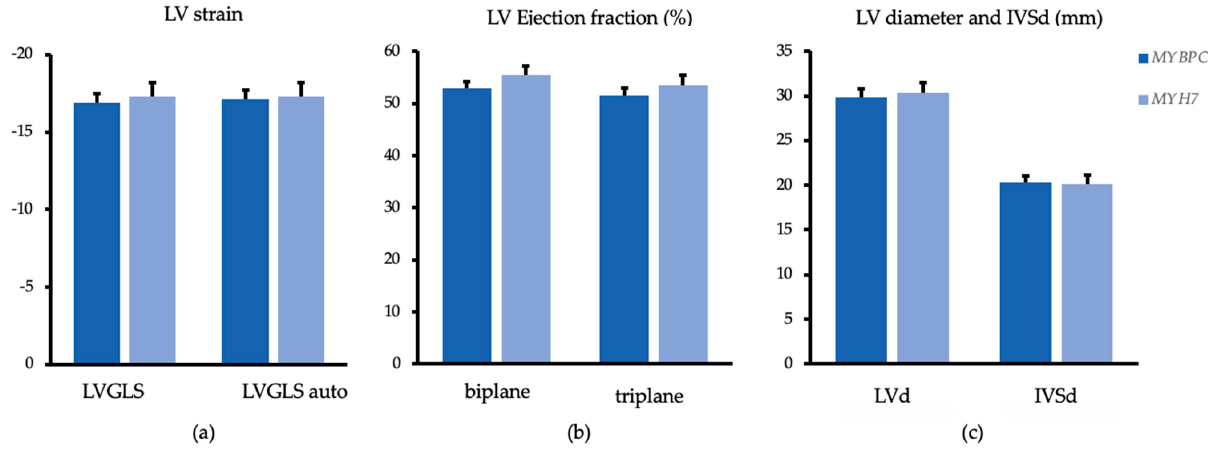
Figure 1. Echocardiographic analysis of the left ventricle. Estimated marginal means and standard error adjusted for age, sex and septum reduction therapy, compared between MYBPC3 (dark blue) and MYH7 (light blue) mutation carriers. ( a ) Left ventricular strain analysis user—(LVGLS) ( p = 0.807) and automatically (LVGLS auto) ( p = 0.892) generated; ( b ) Ejection fraction of the left ventricle (%) measured biplane (Simpson) ( p = 0.338) and triplane ( p = 0.410) in %; ( c ) enddiastolic basal diameter of the left ventricle (LVd) ( p = 0.693) and maximal enddiastolic thickness of the interventricular septum (IVSd) ( p = 0.897).